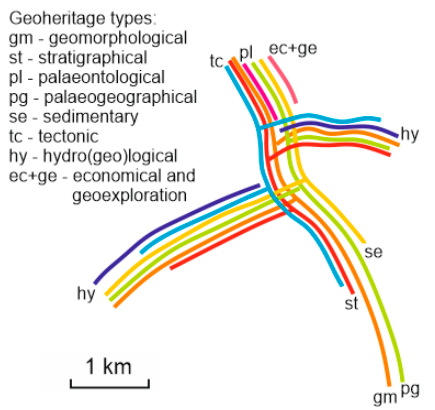
Figure 5. Distribution of geoheritage types in the Khadzhokh Canyon System geosite.